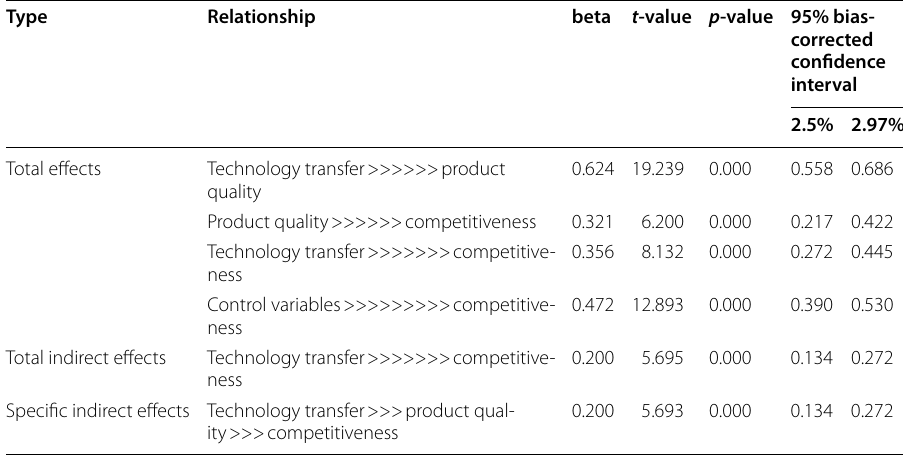
Table 5 Total, total indirect, and specific indirect